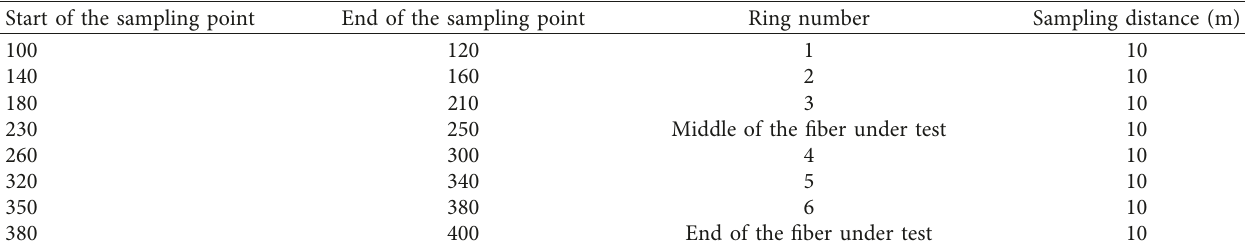
Figure 12: DOVS sensor arrangement. (a) Photo of Hongqiao railway vibration monitoring. (b) Schematic diagram of the optical fiber. Table 4: Optical fiber rings and sampling